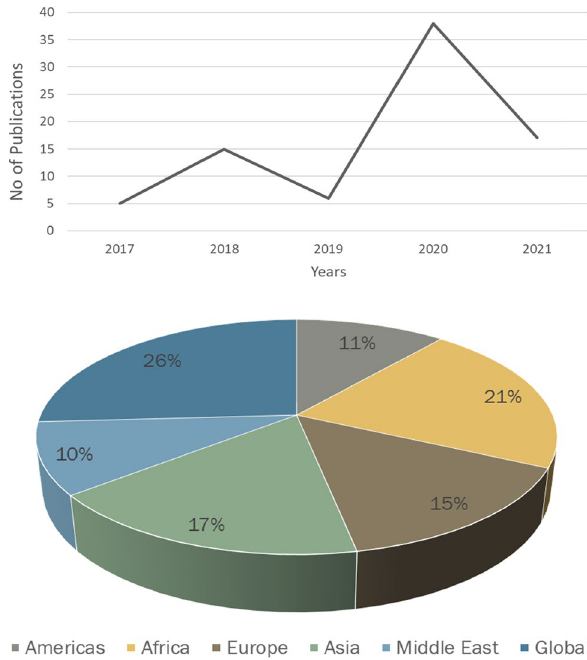
Fig. 5 Sectoral focus of the observed publications Source: